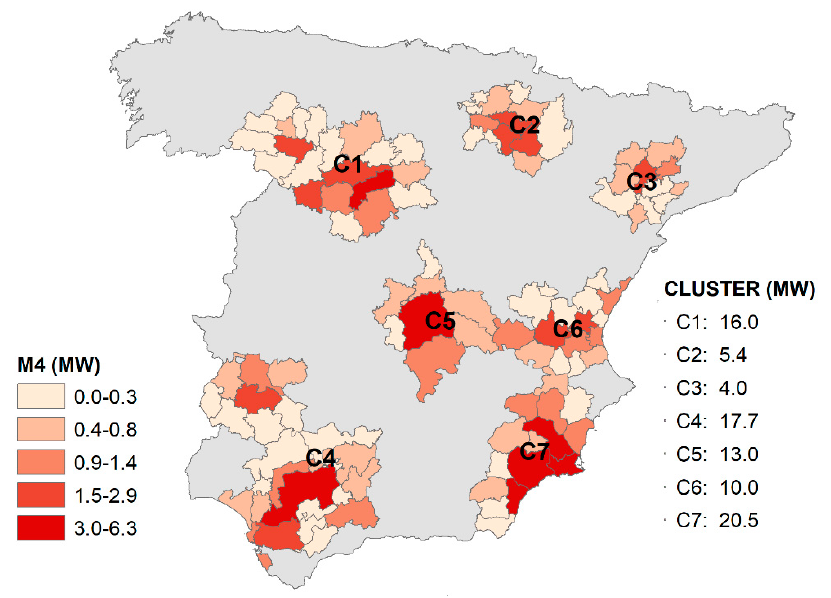
Figure 4. Geographical distribution of the power potential and clusters’ power for mixture M4.